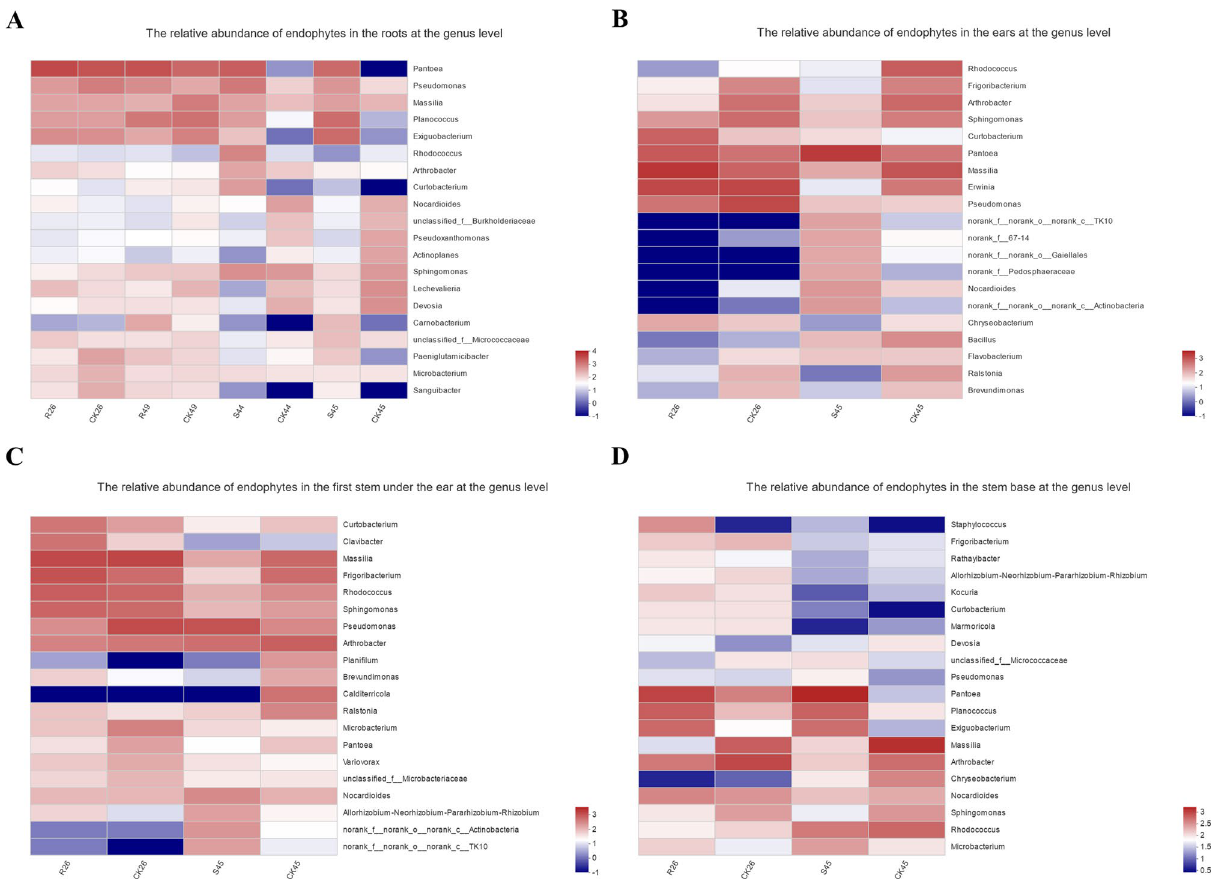
Figure 5. Heatmap of the relative abundance of endophytic bacteria in different tissues of wheat. ( A ) The relative abundance of endophytes in the roots at the genus level. ( B ) The relative abundance of endophytes in the ears at the genus level. ( C ) The relative abundance of endophytes in the first stem under the ear at the genus level. ( D ) The relative abundance of endophytes in the stem base at the genus level. R, resistant variety inoculated with T. controversa ; S, susceptible variety inoculated with T. controversa ; CK, wheat not inoculated with T. controversa ; 26, wheat hybrid variety Mianyang 26/Yumai 47; 49, wheat hybrid variety Yumai 49 * 4/Lankao dwarf 8; 44, wheat variety A-44; 45, wheat variety A-45. The analysis were performed by vegan: Community Ecology Package. R package version 2.5–5 43 . https ://CRAN.R-proje ct.org/packa ge=vegan